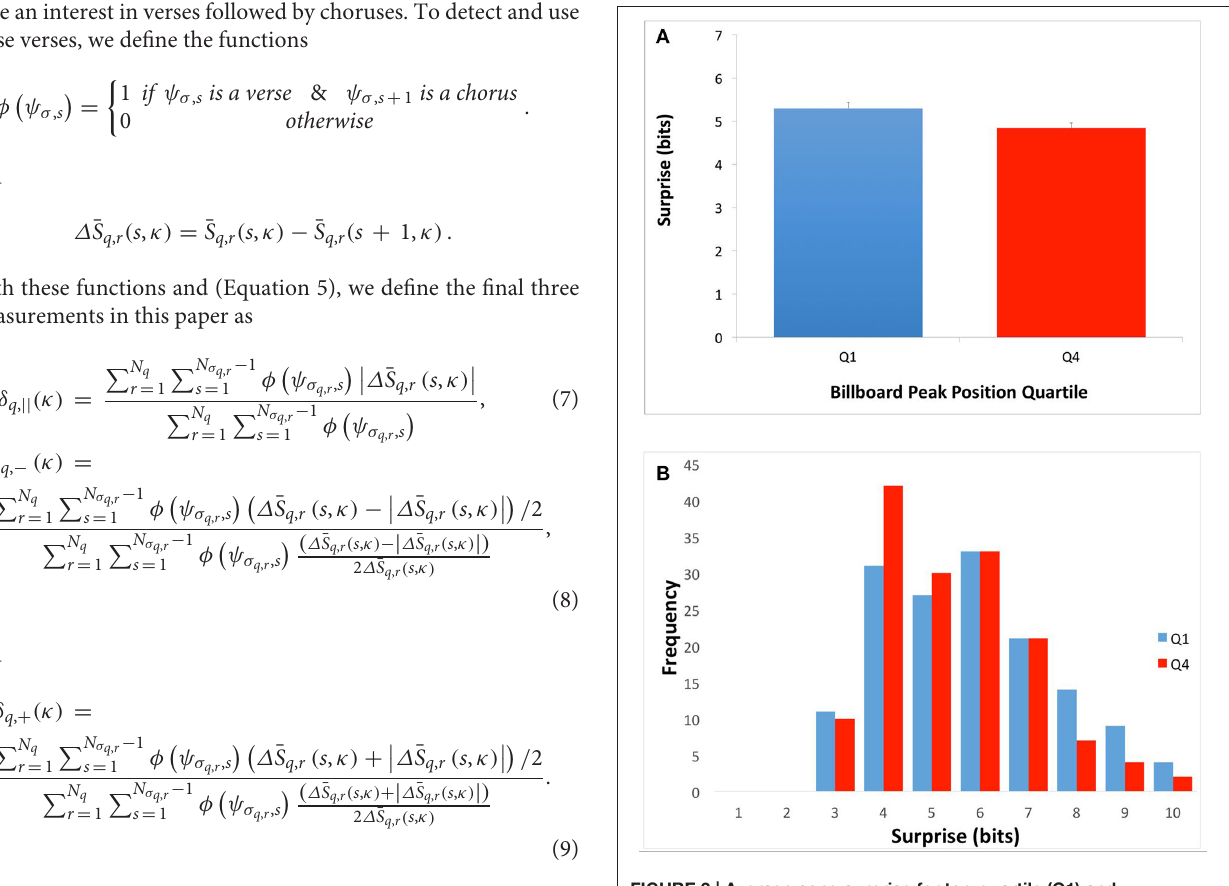
FIGURE 2 | Average song surprise for top-quartile (Q1) and bottom-quartile (Q4) songs. (A) Mean and standard errors of surprise (Equation 2 with κ set to “whole song.”). (B) Frequency of average song surprise for Q1 and Q4. Q1 songs had higher mean surprise than Q4 songs. This superiority of Q1 songs is consistent with the Absolute-Surprise